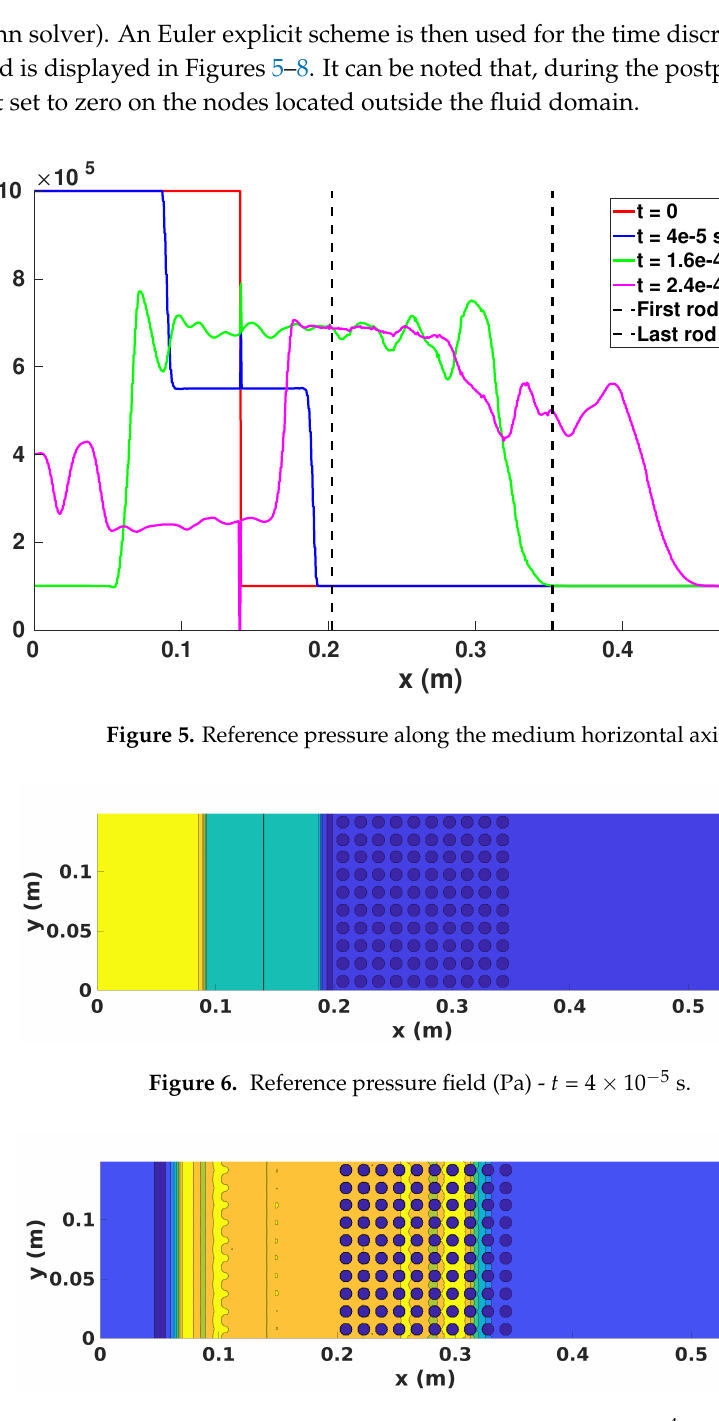
Figure 7. Reference pressure field (Pa) - t = 1.6 × 10 − 4